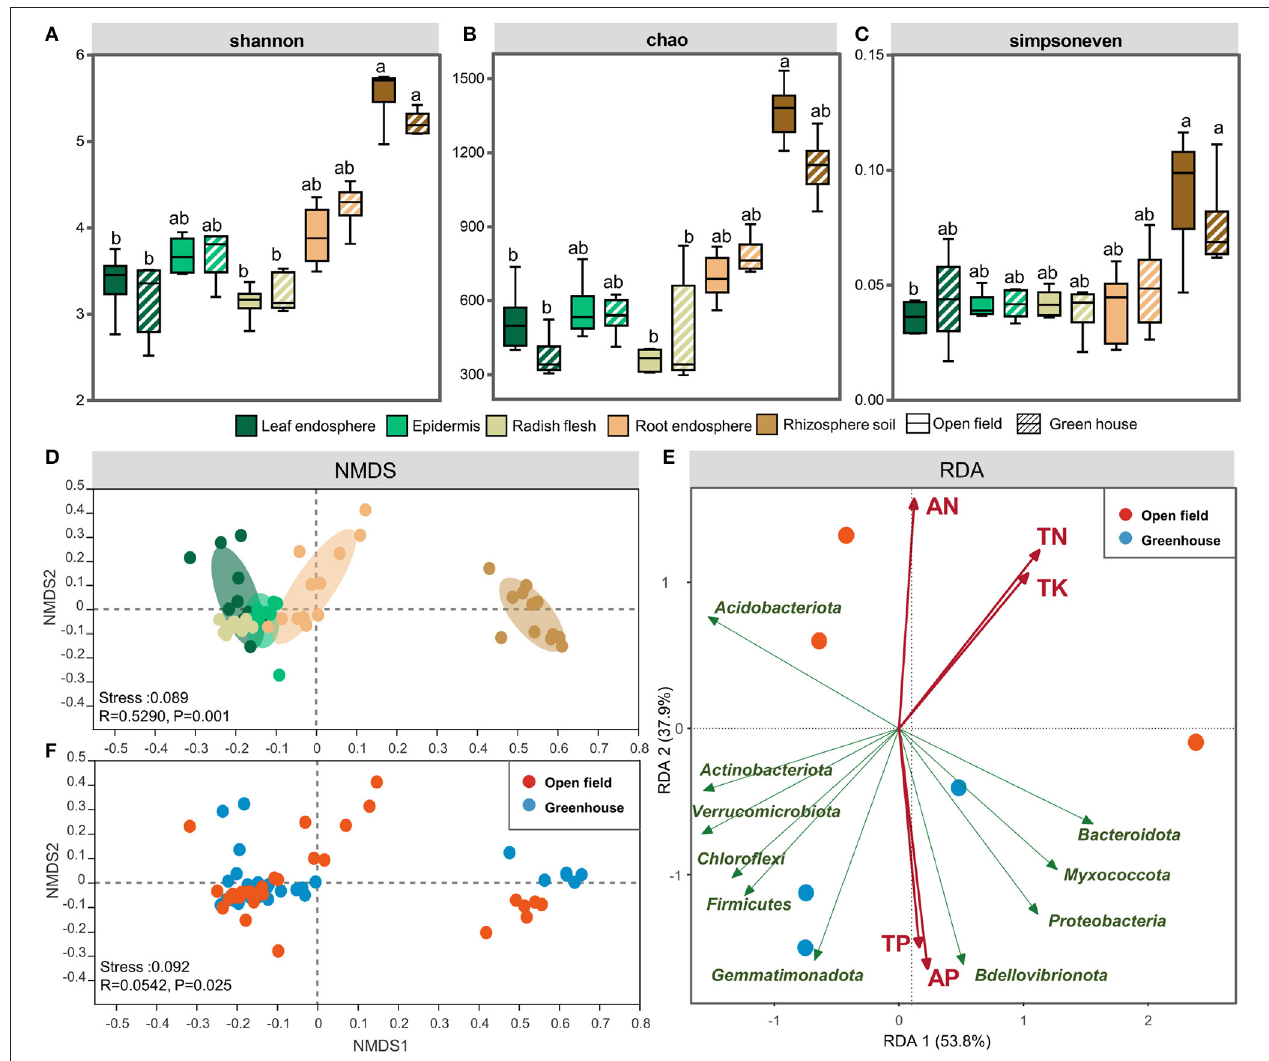
FIGURE 1 | The Shannon (A) , Chao1 (B) , and Simpsoneven indices (C) Shannon index of the leaf endosphere, epdermis, radish flesh, root endosphere, and rhizosphere soil in open field and greenhouse. NMDS analysis of different ecological compartments (D) and cultivation environments (F) . Redundancy analysis (RDA) of the bacterial community in open field and greenhouse growth conditions (E) . The bar represents the median, and whiskers represent the minimum and maximum values. Data were calculated by means of a Kruskal–Wallis test. Significant differences are indicated with different lowercase letters ( P < 0.05). The NMDS results were colored using the Bray-Curtis method. Different colors represent different plant compartments. Statistical data were analyzed by